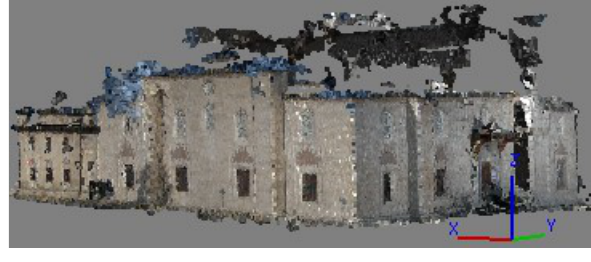
Fig.6. Point cloud